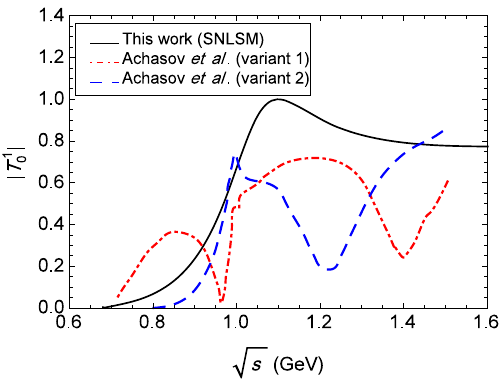
Fig. 4 Comparingthepredictionofthesinglenonetlinearsigmamodel (SNLSM)forthemodulusof T 1 withthepredictionofRef.[150],where 0 up to about 1 GeV, a qualitative agreement with “variant 2” is